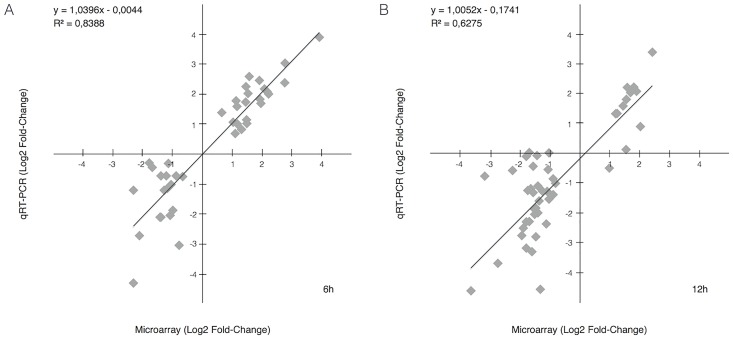
Validation of microarray data with qRT-PCR.Correlation between qRT-PCR and microarray analysis at 6h (A) and 12h (B). The correlation coefficients (R2) are 0.83 and 0.62, respectively.